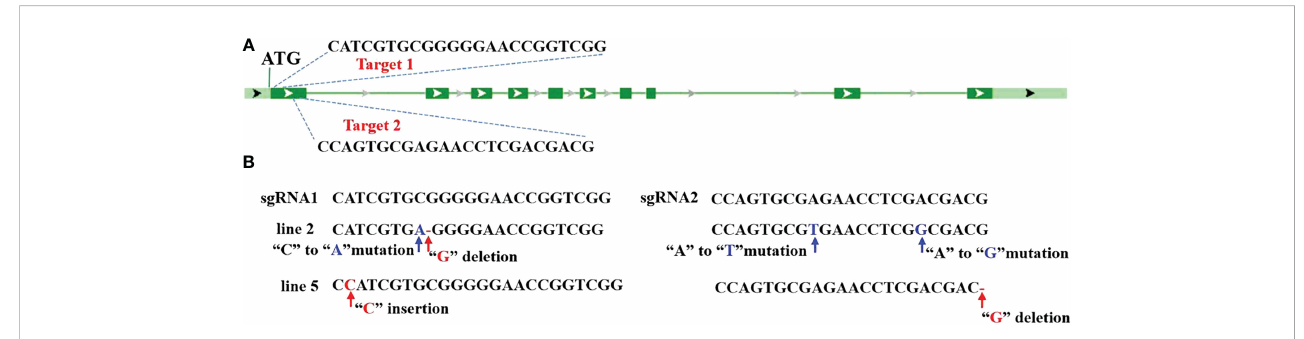
FIGURE 1 CRISPR/Cas9-mediated editing of Osv-ATPase d (A) Illustration of Osv-ATPase d gene structure and the editing target. (B) Mutant sites at Osv-ATPase d.